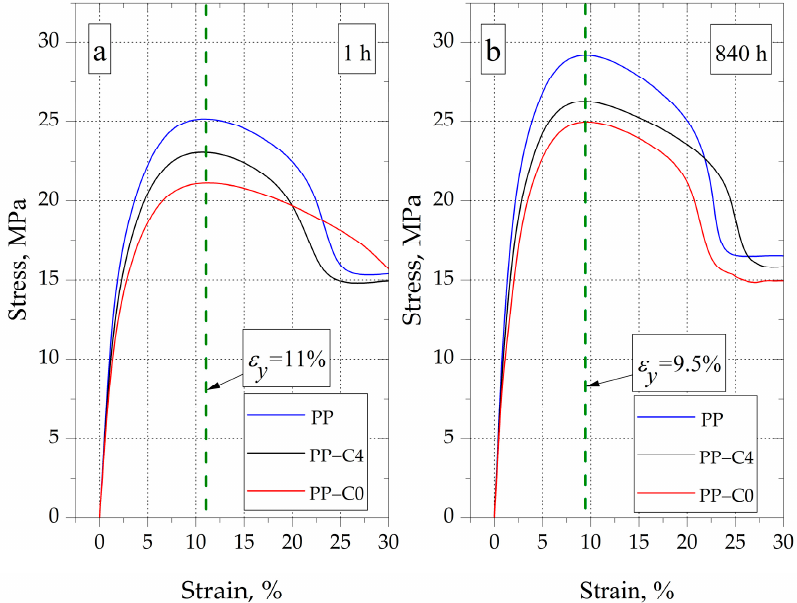
Figure 9. Examples of tensile curves of PP samples; after 1 h of conditioning ( a ), after 840 h of conditioning ( b ).